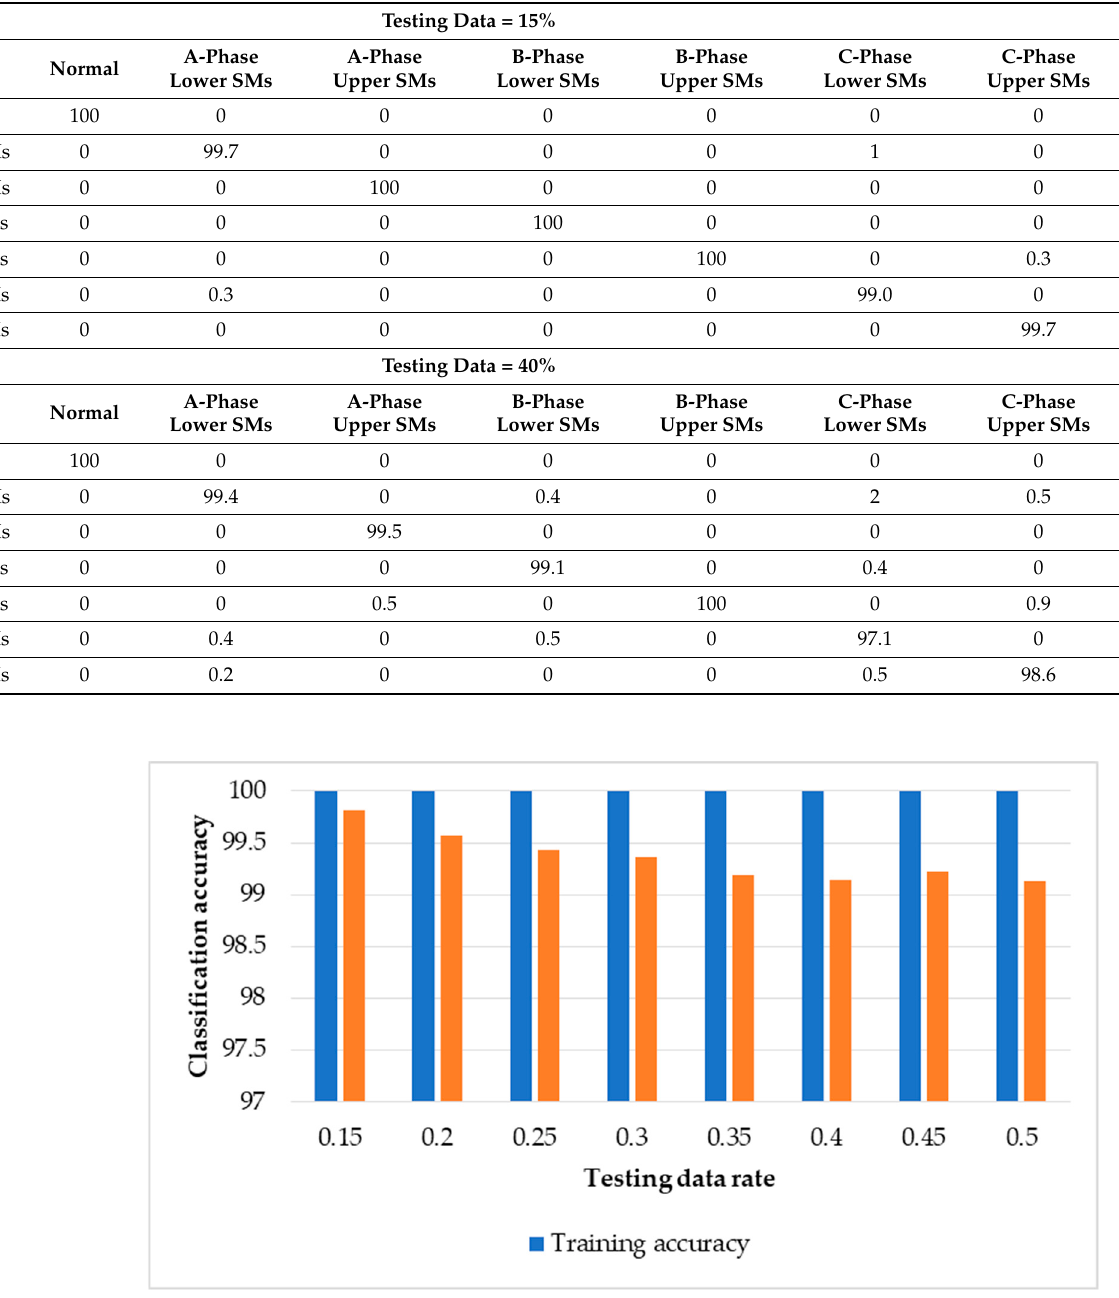
Figure 9. Classification results of training and testing data using MLR with data normalisation.